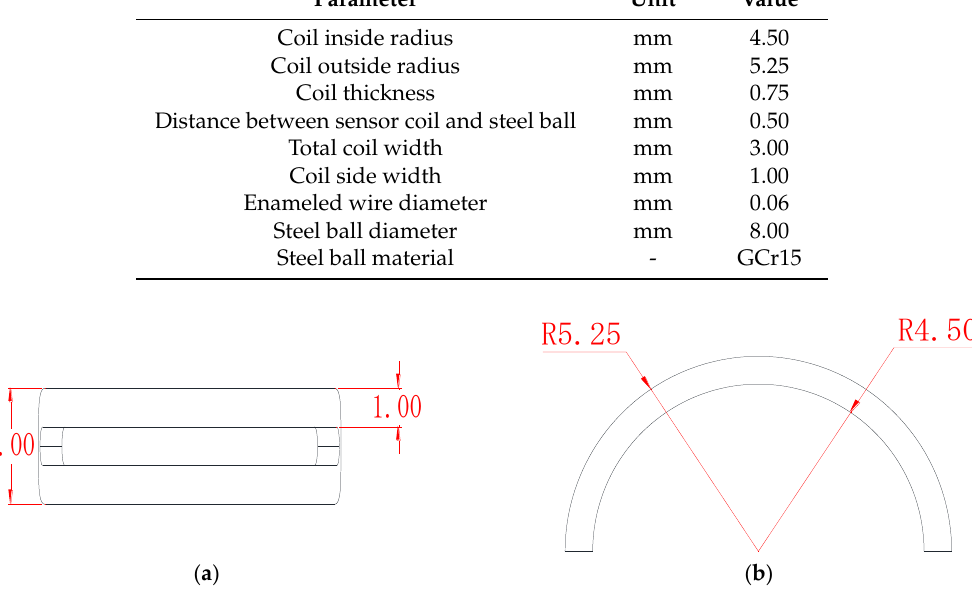
Figure 5. Outline dimensions of the SECS coil (the unit is mm). ( a ) The top view of coil; and ( b ) the main view of coil.